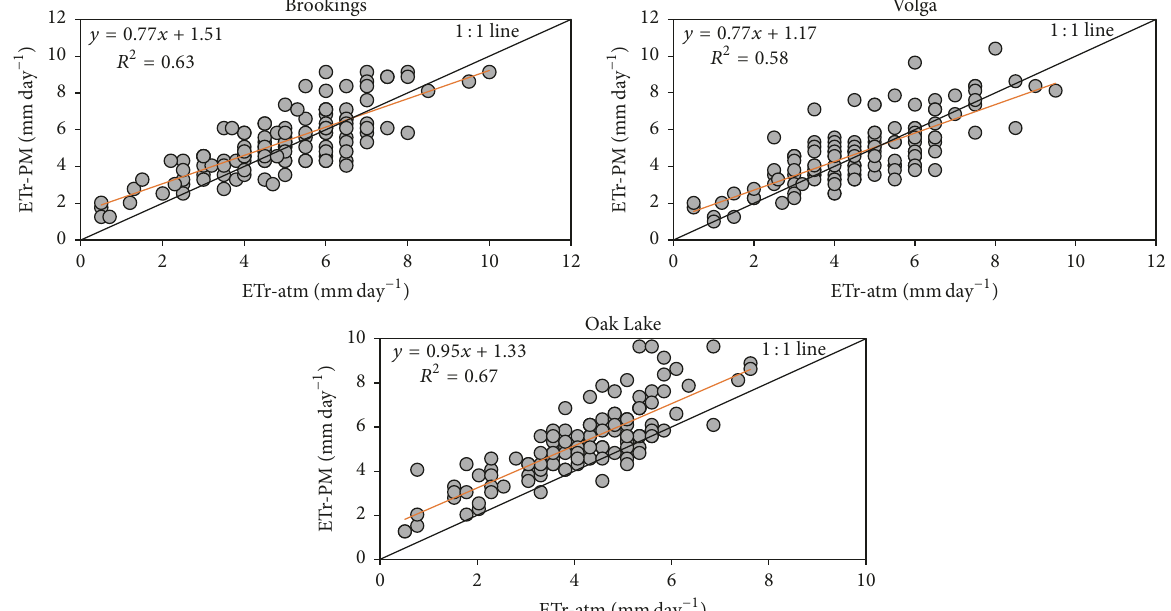
Figure 5: Relationship between ET growing